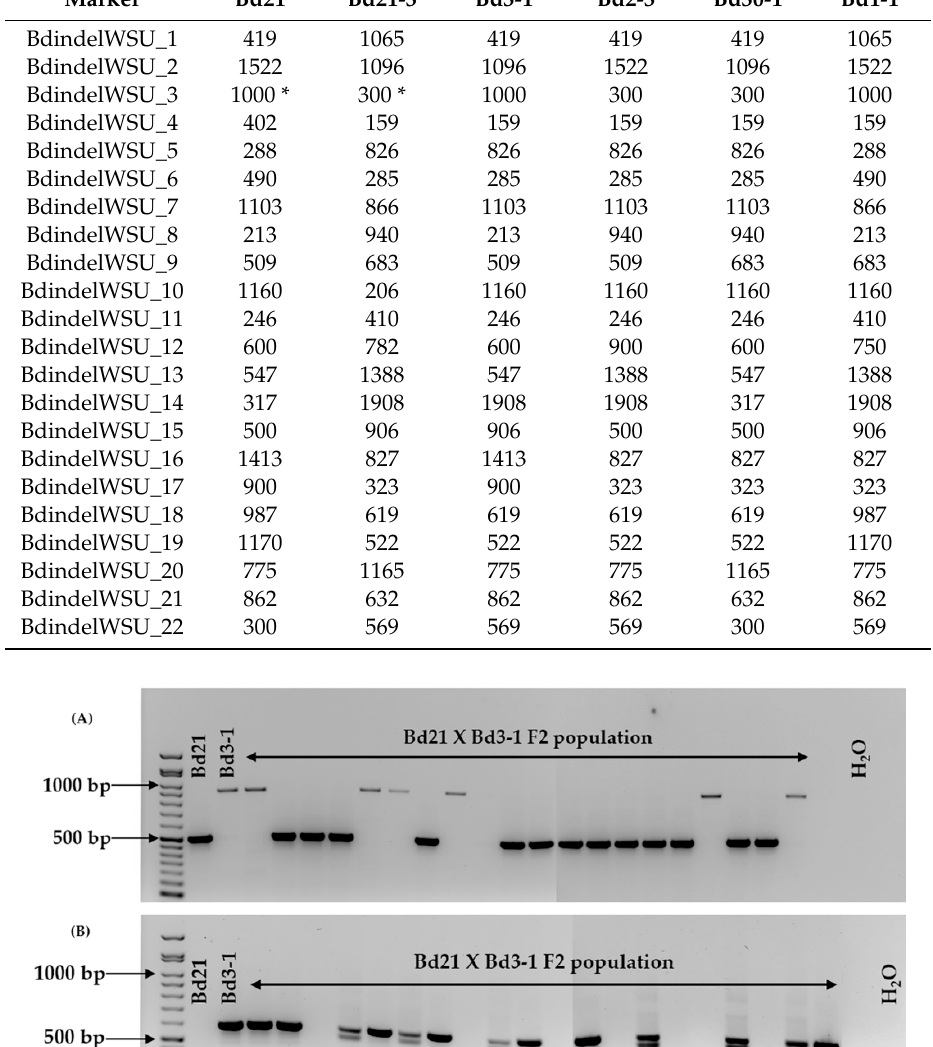
Table 2. Nucleotide sizes of major and discriminating amplicons obtained for six Brachypodium distachyon accessions using 22 designed indel markers. Values shown are the main bands used for accession discrimination under the conditions tested. * Indicates amplicon size larger than predicted.